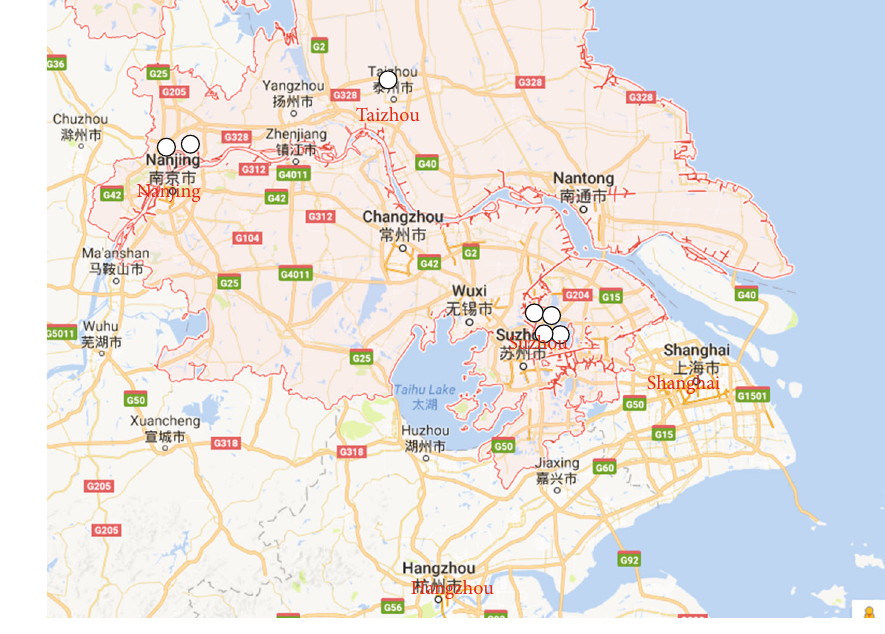
Figure 2: Map of the CPTU sites. Table 1: Soil properties and description of